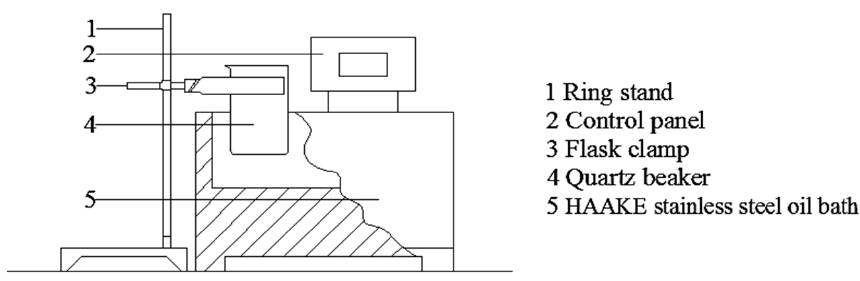
Figure 9. The device of rapid conventional heating: a HAAKE stainless steel oil bath.